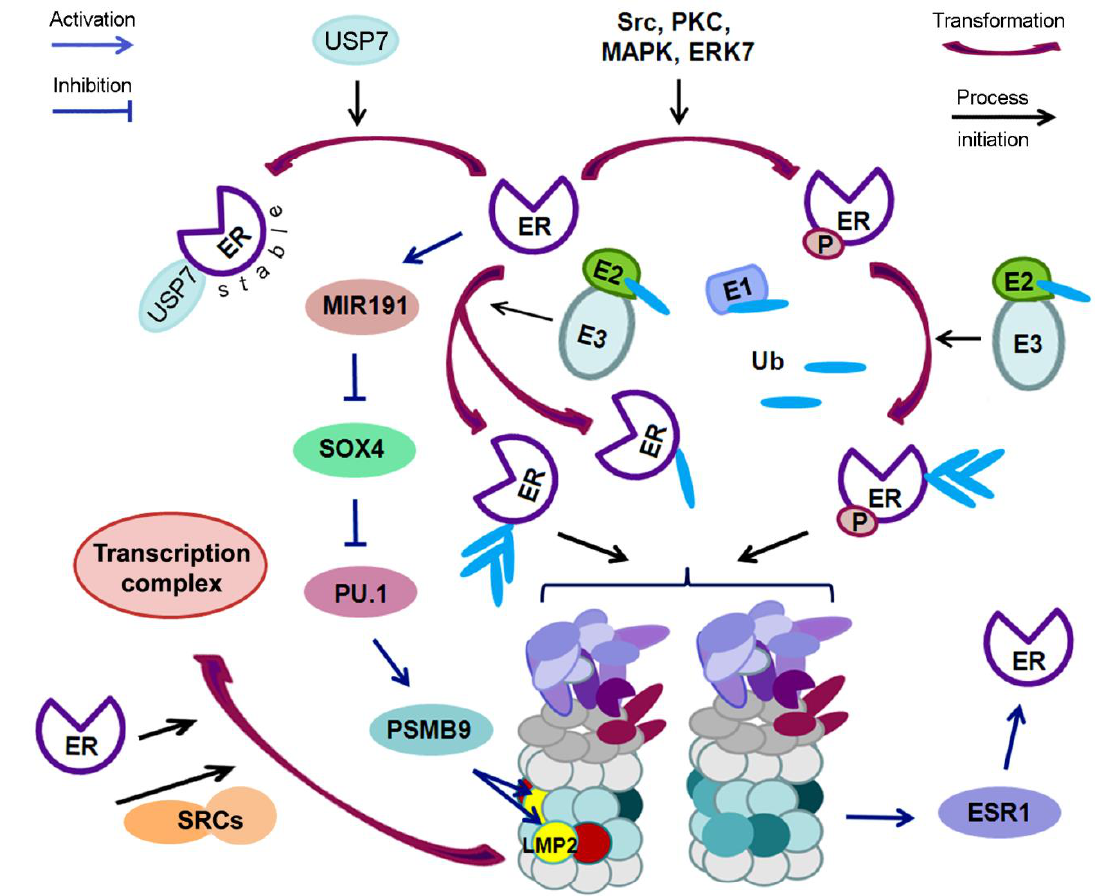
Figure 3. Scheme of the mutual regulation of estrogen receptors and ubiquitin proteasome system. ER — estrogen receptor; P — phosphate group; Src, PKC, MAPK, ERK7 — protein kinases; USP7 — ubiquitin specific protease 7; E1 — ubiquitin-activating enzyme; E2 — ubiquitin-conjugating enzyme; E3 — ubiquitin protein ligase; Ub — ubiquitin; ESR1 — gene encoding ER α ; SRCs — steroid receptor coactivators; MIR191 — miRNA 191; SOX4, PU.1 — transcription factors; LMP2 — large multifunctional peptidase 2 (immune proteasome subunit); PSMB9 — gene of proteasome subunit beta type 9 (LMP2).